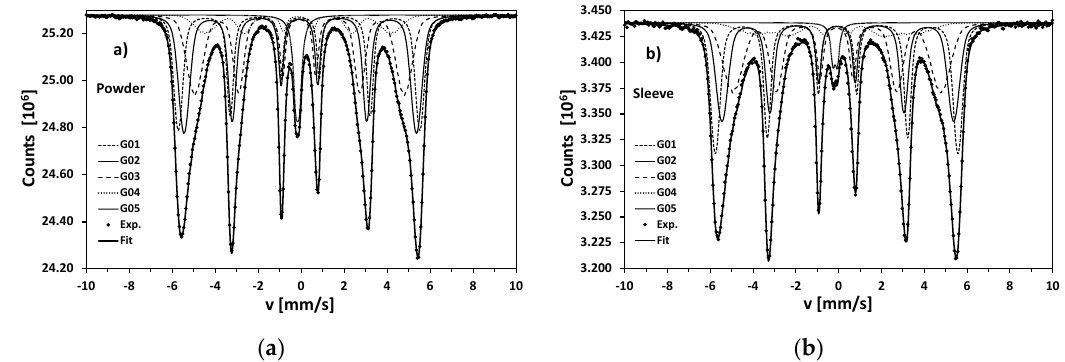
Figure 15. Room temperature transmission Mössbauer spectra for the initial powder and ready sleeve: ( a ) initial powder; ( b ) SLM fabricated sleeve. The components G01–G04 represent martensite while G05 does retained austenite.